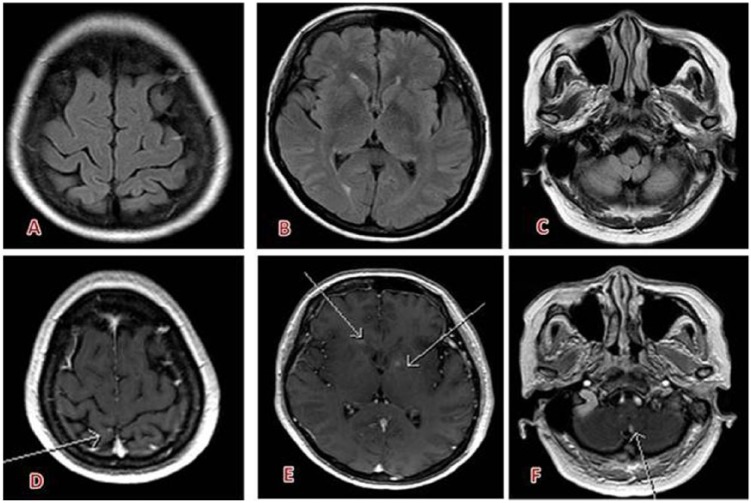
Multiple small brain metastases (breast cancer) visible only on T1-weighted sequences after intravenous contrast injection (gadobutrol, 7.5 mL) (D) right parietal lesion, (E) left lenticular and right head of caudate lesions, (F) left cerebellar lesion and not on (A-C) fluid-attenuated inversion recovery sequence.